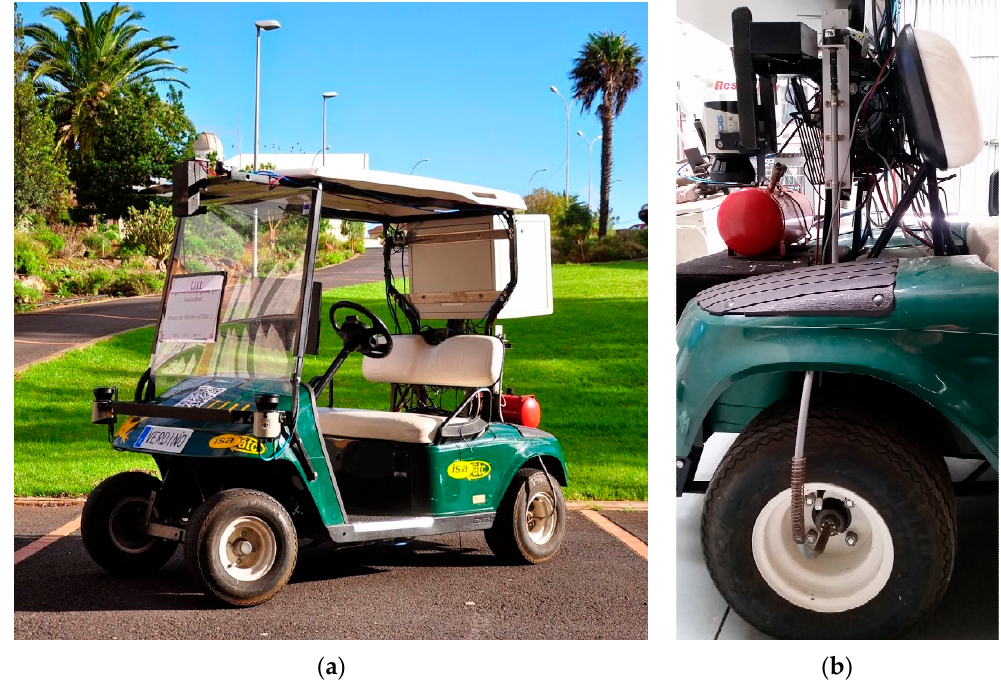
Figure 1. ( a ) Verdino autonomous golf cart; and, ( b ) odometric sensor based on a flexible link from the center of the wheel to the encoder placed in the vehicle.